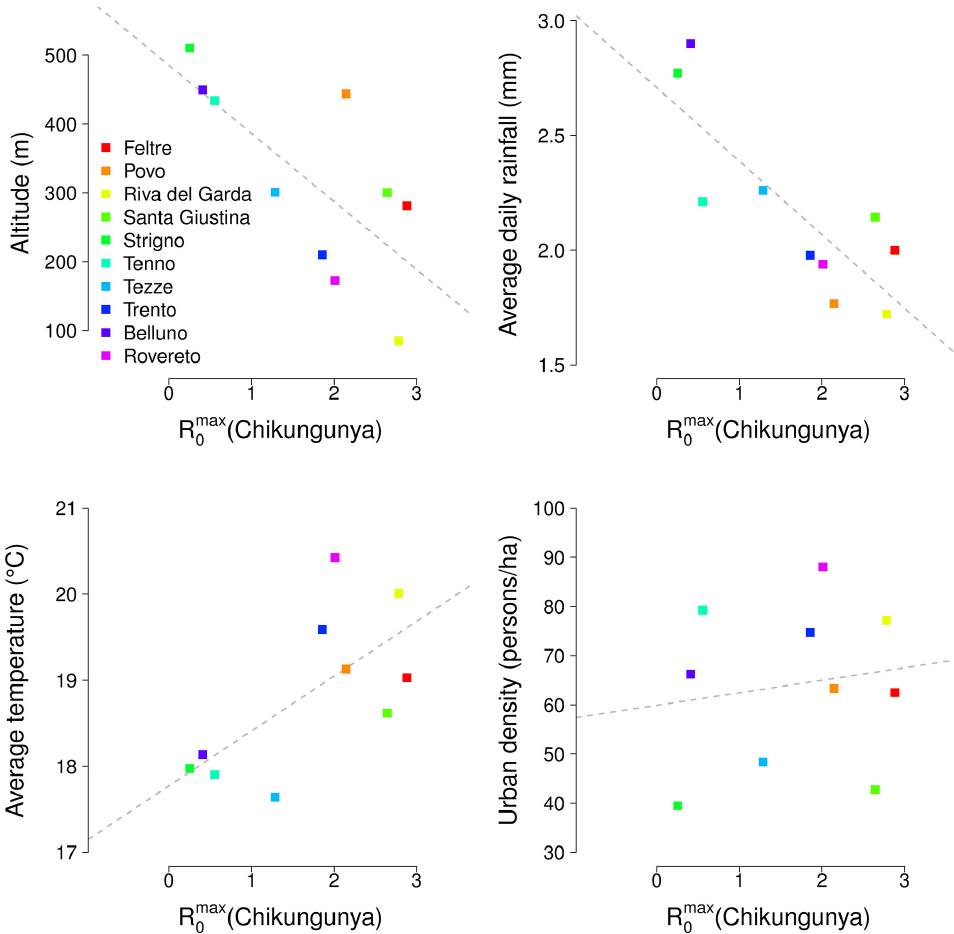
Fig 4. Scatterplots of the predicted peak of R 0 for chikungunya at different sites and corresponding local variables; dashed lines represent regression lines.